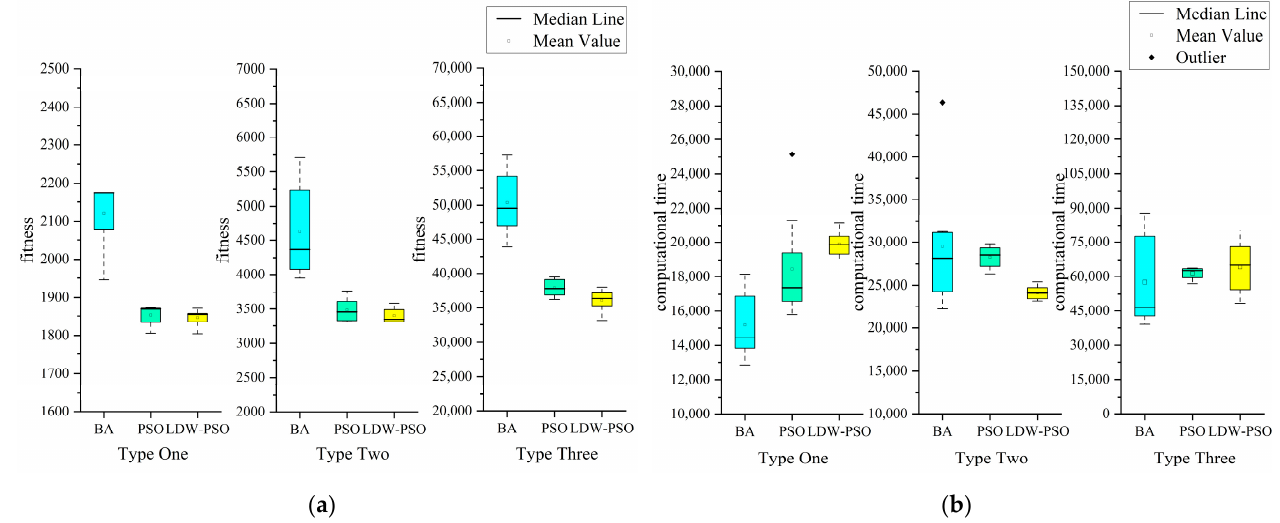
Figure 6. Boxplot representation of distribution results. ( a ) fitness; ( b ) computational time.